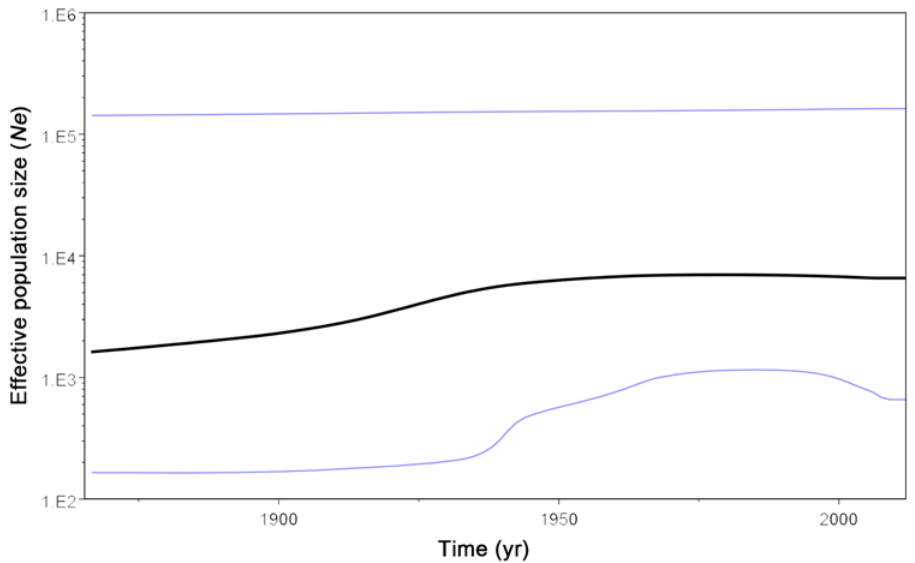
Fig 5. Bayesian skyline plot based on the entire genome sequences of 37 CSFV isolate. The plot depicts changes in the effective population size ( N e ). The dark line shows the effective population size estimated through time. The upper and lower lines indicate the 95% HPD range of